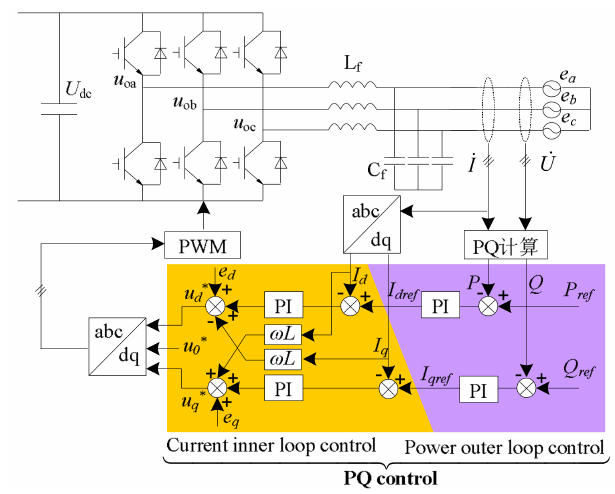
Figure 12. Control Strategy of Traditional PV Storage